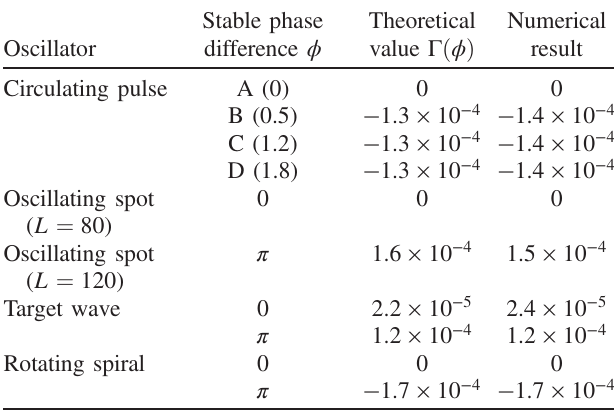
TABLE I. Shift in the frequency of the phase-locked rhythmic spatiotemporal patterns. Theoretical values of the frequency shift Γ ð ϕ Þ , obtained using the theoretical phase-sensitivity function, are compared with those measured by direct numerical simu- lations. Stable phase differences in the cases B, C, and D of the circulating pulses are obtained by direct numerical simulations.